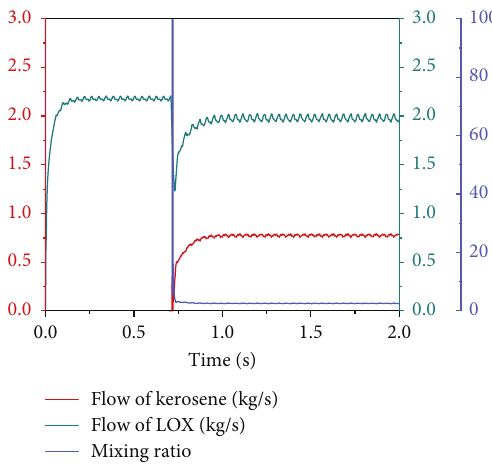
Figure 14: Propellant fl ow at the moment of start-up process in variable thrust conditions.